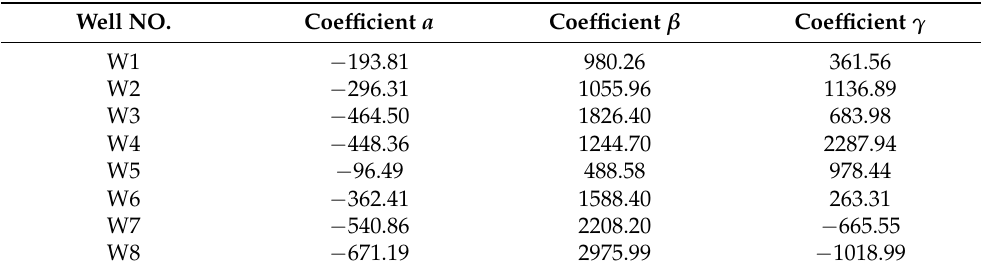
Table 3. Coefficients of GLEPCs of various wells. Well